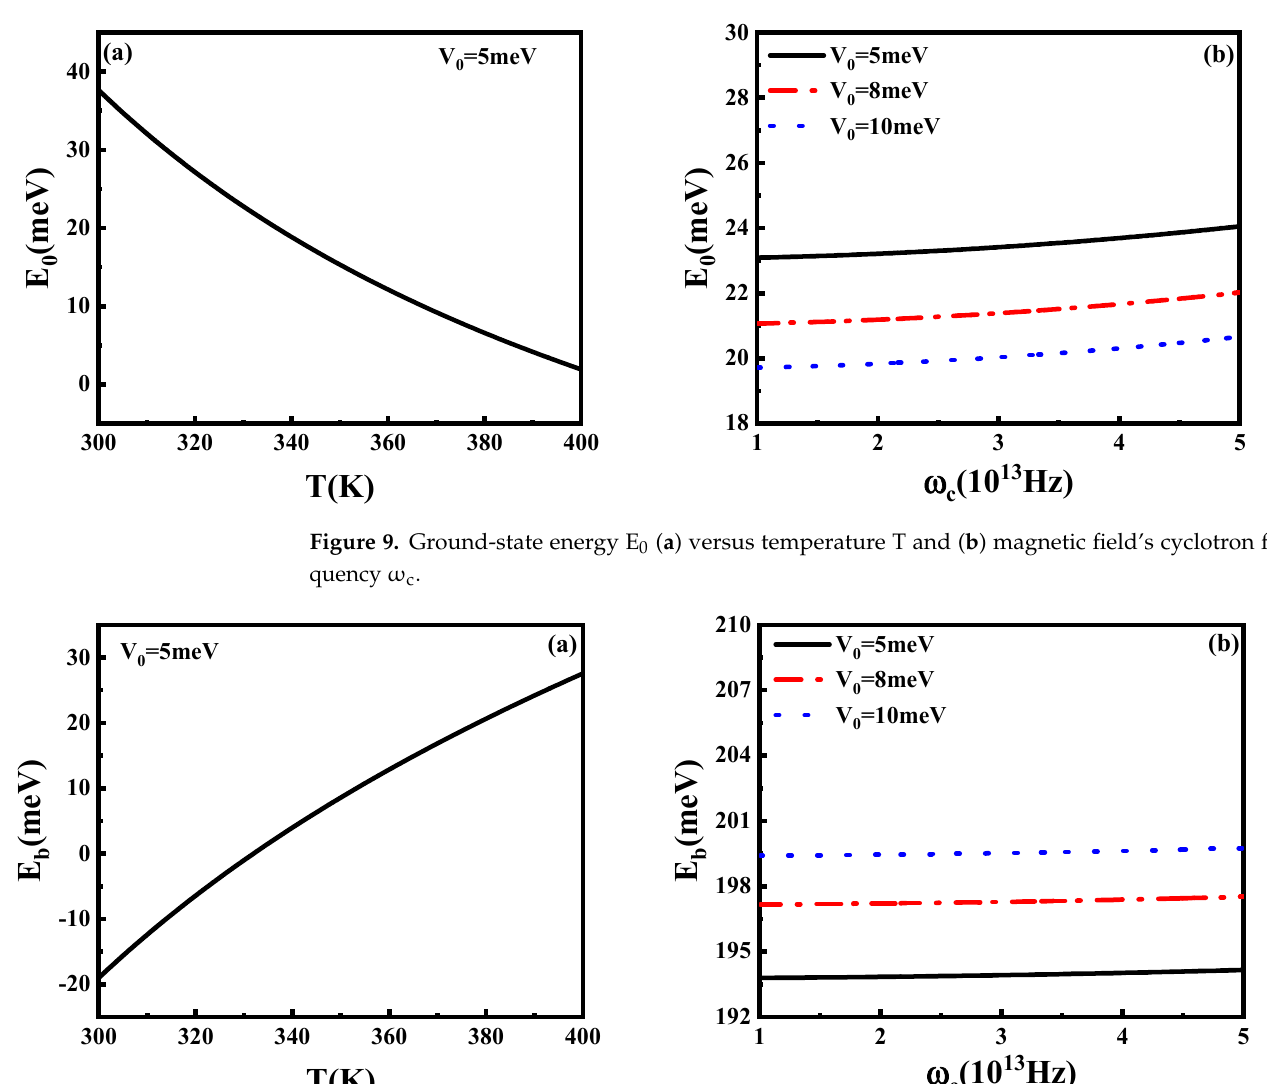
Figure 10. Ground-state binding energy E b versus ( a ) temperature T and ( b ) magnetic field’s cyclotron frequency ω c .